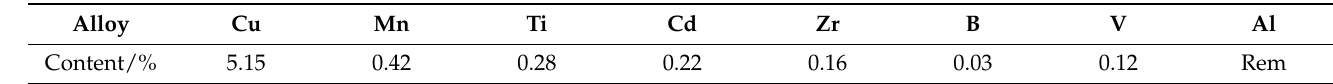
Table 1. Chemical composition of the raw material